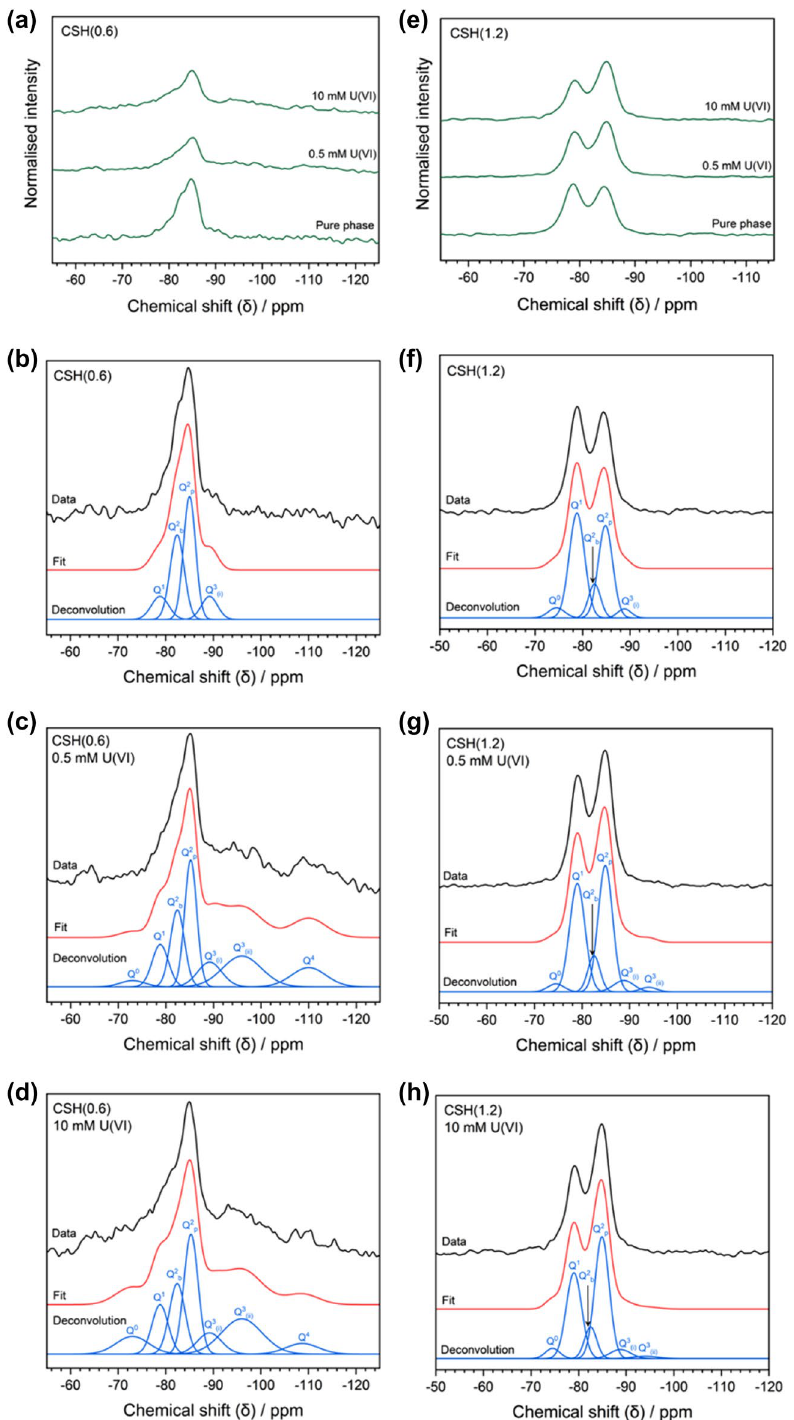
Figure 7. Normalised 29 Si MAS-NMR spectra of CSH samples. ( a ) Normalised 29 Si MAS-NMR spectra of CSH(0.6) under varying U(VI)-contacting conditions; ( b–d ) non-normalised 29 Si spectra of CSH(0.6) under various U(VI)-contacting conditions with Si Q n species deconvolution; ( e ) normalised 29 Si spectra of CSH(1.2) under various U(VI)-contacting conditions and; ( f–h ) non-normalised 29 Si spectra of CSH(1.2) under various U(VI)-contacting conditions with Si Q n species